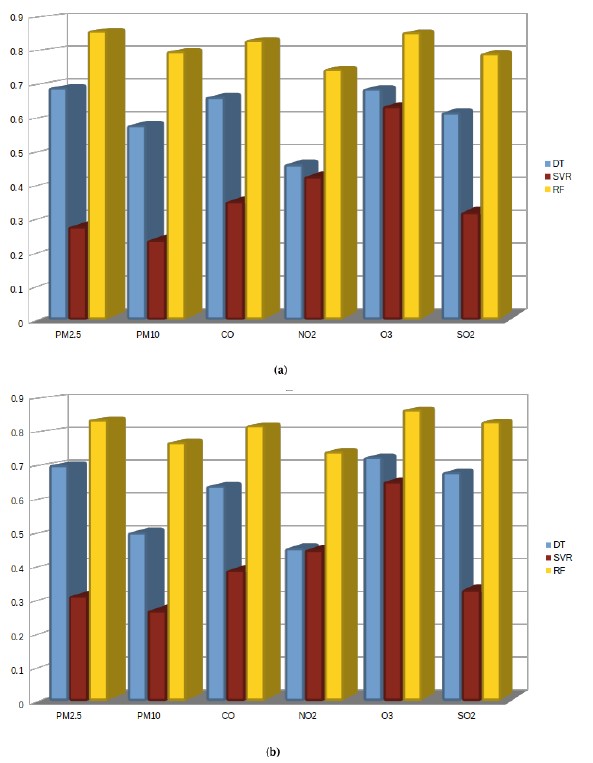
Figure 4. Visualization of R 2 scores obtained in all experiments, (a) for Guanyuan City Weather Station Data, and (b) for Wanshouxigong Weather Station